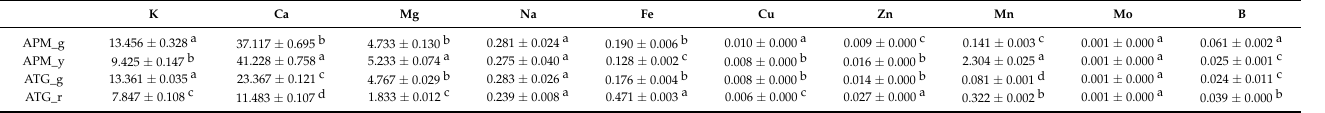
Table 1. Mineral element contents of APM and ATG leaves in different seasons (mg/g DW). K Ca Mg Na Fe